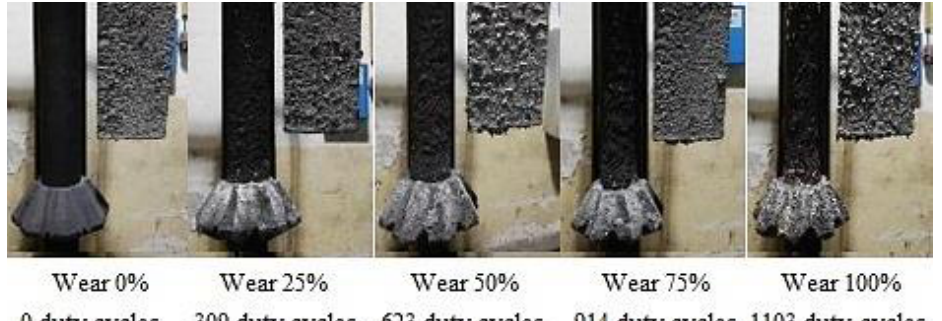
Figure 5. Type C rotor wear.